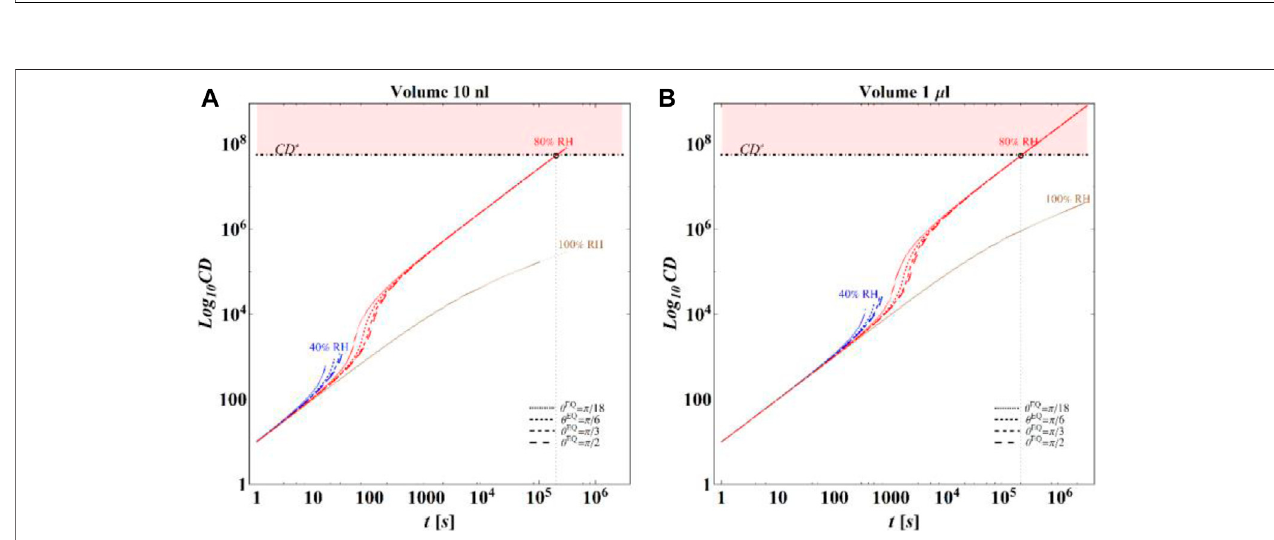
FIGURE10| Results ofmodel calculationsoftheevaporation process ofasessiledropofaqueous solutionintermsoftime evolutionof CD forastartingvolumeof the drop equal to (A) 10 nL and (B) 1 μ L, at an RH (cid:2) 40, 80, and 100%, for fl at surfaces withdifferentwettability and at T (cid:2) 25 ° C. As for Figures3 , 6 at RH (cid:2) 100%,only the calculations performed for an initial contact angle equal to π / 18 are